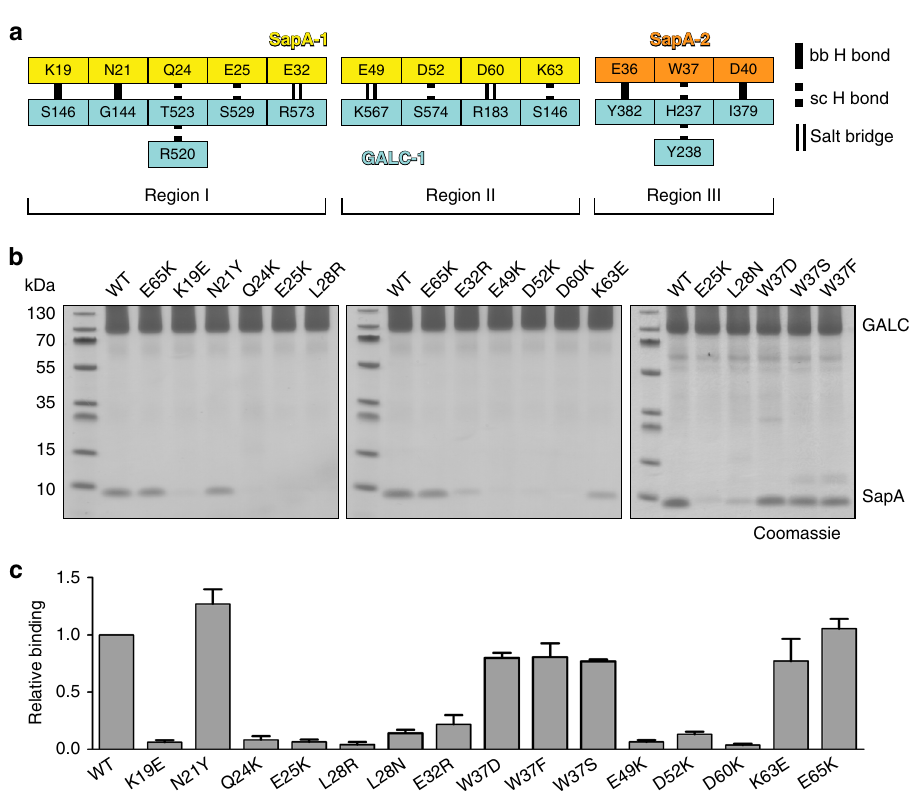
Fig. 4 Critical residues at the GALC – SapA interface. a Schematic diagram illustrating the backbone (bb) hydrogen bonds, sidechain (sc) hydrogen bonds and salt bridges observed between GALC (cyan) and speci fi c residues of SapA chains 1 (yellow) or 2 (orange). Note that SapA residues Q24 and W37 interact with multiple GALC residues. b Coomassie-stained SDS – PAGE of pulldown assays with immobilised GALC performed in the presence of Tween-20 identi fi es critical SapA mutations at the interface that abolish GALC binding in solution. c Quanti fi cation of SapA binding in pulldown assays ( n = 3, error bars represent